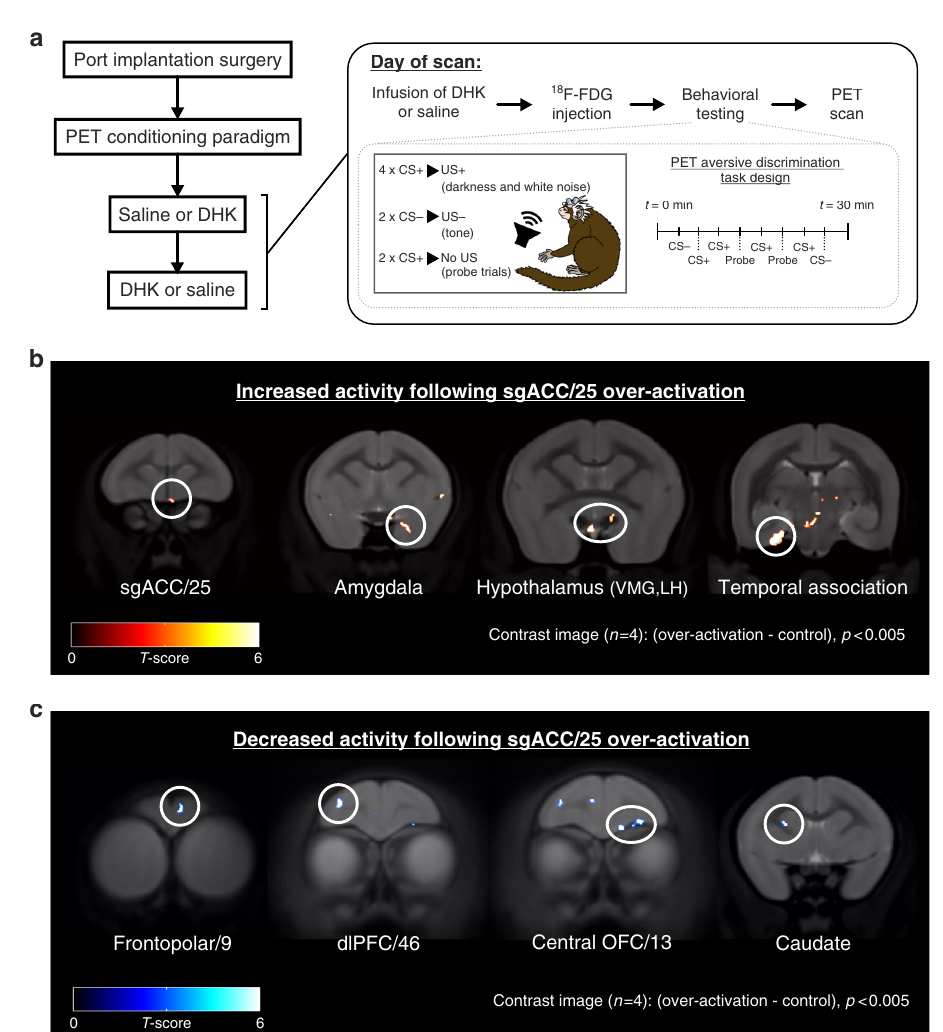
Fig. 5 Circuit-wide changes associated with sgACC/25 over-activation revealed with 18 F-FDG PET imaging. a Four marmosets had a subcutaneous port implanted into the jugular vein and were trained on a lengthened version of the aversive Pavlovian discriminative conditioning test in preparation for scanning. Saline (control) and DHK (over-activation) scans were counterbalanced. On the day of the scan (inset), animals were infused with saline or DHK and immediately injected with 18 F-FDG ligand through the port. The conditioning session lasted 30 min to increase sensitivity of the ligand to perturbations in brain activity caused by the paradigm. On the day of scans, this consisted of four CS + /US + pairings, two CS − /US − pairings and two “ probe ” trials of a CS + alone to limit aversive US exposures. These were presented in a fi xed order indicated on the timeline. b Contrast images calculated from standardized uptake value ratio (SUVR) maps of over-activation — control scans, showing brain regions with increased activity following over-activation. These included sgACC/25, the amygdala, the ventromedial (VMH) and lateral (LH) hypothalamic nuclei and temporal association area TH ( p < 0.005, uncorrected). c Contrast images calculated from SUVR maps of control — over-activation scans, showing brain regions with reduced activity following over-activation. These included frontopolar cortex/9, dorsolateral prefrontal cortex (dlPFC)/46, central orbitofrontal cortex (OFC)/13 and the lateral caudate ( p < 0.005, uncorrected). Source data are available from the corresponding author upon